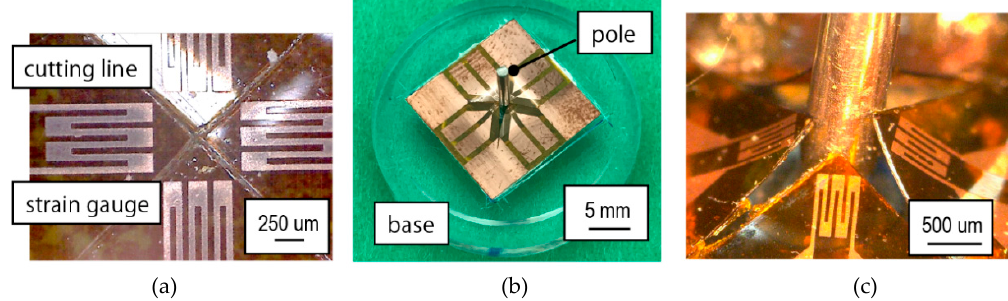
Figure 5. Photographs of ( a ) the fabricated strain gauge, ( b ) the assembled device, and ( c ) deformation of the polyimide substrate with strain gauges when load is applied.